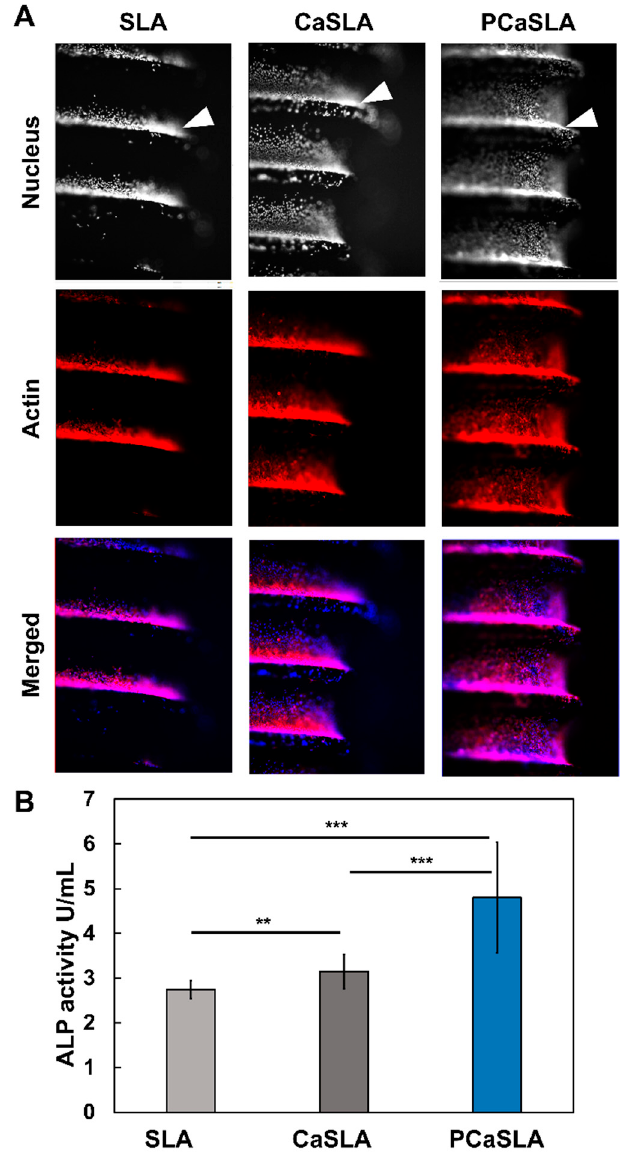
Figure 5. ( A ). Fluorescence images of cells labelled with Rhodamine phalloidin, and Hoechst 33,342 adhere on SLA, CaSLA, and PCaSLA surfaces (Nucleus images in the top row are shown in grey scale images. Actin images in the middle row are shown in red color. In the bottom row, the merged images show the nucleus in blue color and actin in red color. ( B ). ALP activity of cells on SLA, CaSLA, and PCaSLA at the 7th day of culture. [** p < 0.01, *** p < 0.001].